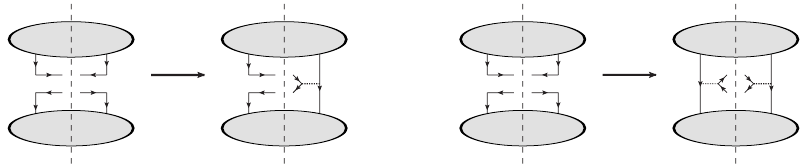
Figure 1 . Contributions to the matrix element squared, in which in the left (right) two diagrams one (both) U ( N ) gluon(s) is (are) replaced by U (1) gluon(s) on the left or (and) right of the C unitarity